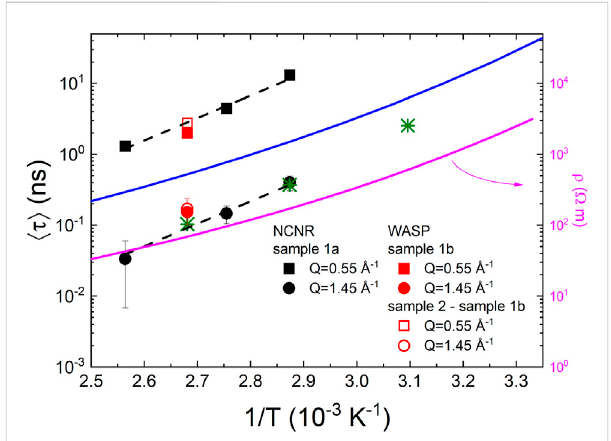
FIGURE 4 Arrhenius plot of the average relaxation times. The green asterisks are the data reported in (16) for Q = 1.5 Å − 1 . The blue line reports the temperature dependence of the relaxation time obtained with dielectric spectroscopy on P(EO) 10 LiTFSI (Do et al., 2013). The magenta line, referring to the right axis, is the conductivity, estimated using the parametrization outlined in ref. (Zheng et al., 2018). The dashed lines are the results of a global fi t to an Arrhenius law (equation). Error bars represent standard